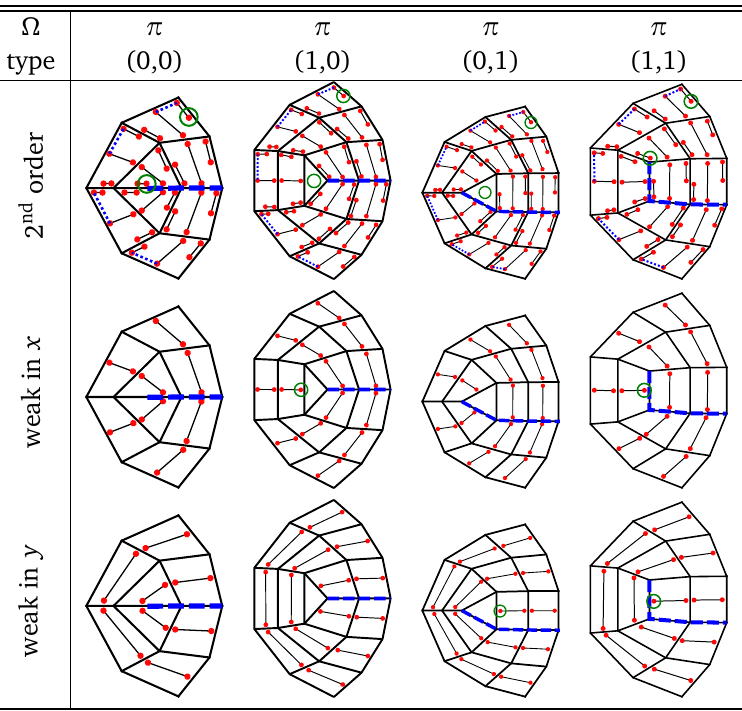
Figure 7: Decorations of twofold rotation-symmetric lattices with π disclinations of all types as defined in Fig. 2: decorations with second-order topological phases pro- tected by twofold rotation symmetry and decorations with weak topological phases as stacks in the x and y directions. Red dots represent d − 2 dimensional anomalous states with (cid:90) topological charge. Dashed blue lines indicate the branch cut in the 2 Volterra process across which anomalous states hybridize. Green circles denote loca- tions where unpaired anomalous states remain. Note that for weak phases hosting an anomalous disclination state, there is also an odd number of anomalous states on the boundary.